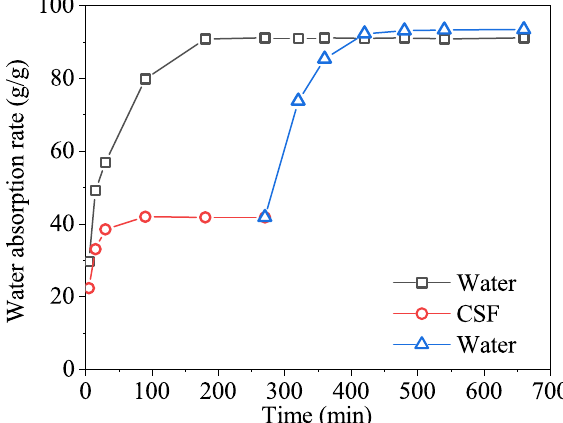
Figure 6. The absorption rate of the SAP in water and in CSF at 90 ◦